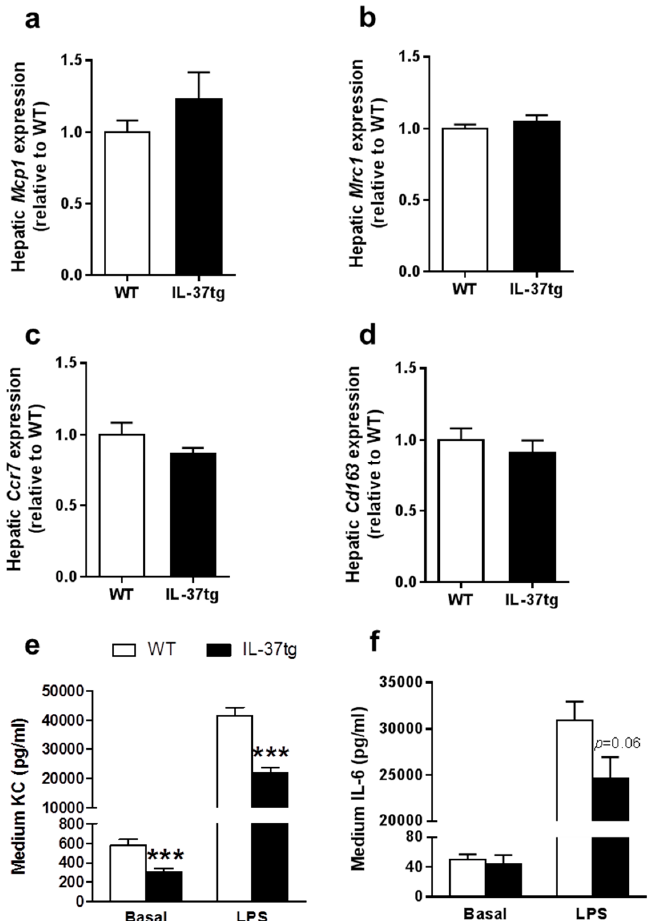
Figure 3. Expression of IL-37 reduces lipopolysaccharide (LPS)-induced cytokine secretion by peritoneal macrophages ex vivo. At the end of the study, after eight weeks of Western-type diet (WTD)-feeding, mice were killed and both liver samples and peritoneal macrophages were isolated. RT-qPCR was used to measure hepatic mRNA expression of the M1 phenotype markers monocyte chemotactic protein 1 ( Mcp1 ) ( a ) and mannose receptor C-type 1 ( Mrc1 ) ( b ); In addition, the M2 phenotype markers C-C chemokine receptor type 7 ( Ccr7 ) ( c ) and cluster of differentiations 163 ( Cd163 ) ( d ) were measured ( n = 15 per group). Peritoneal macrophages were ex vivo stimulated with lipopolysaccharide (LPS; 10 ng·mL ⁻ 1 ) or saline as a control for 24 h; Keratinocyte chemoattractant (KC; ( e )) and IL-6 ( f ) were determined in the medium ( n = 8 per group). Data are expressed as means ± SEM; *** p < 0.001.